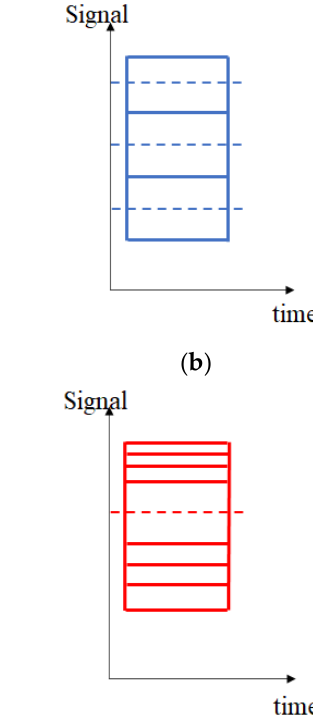
Figure 1. Overall schematic of the proposed scheme.